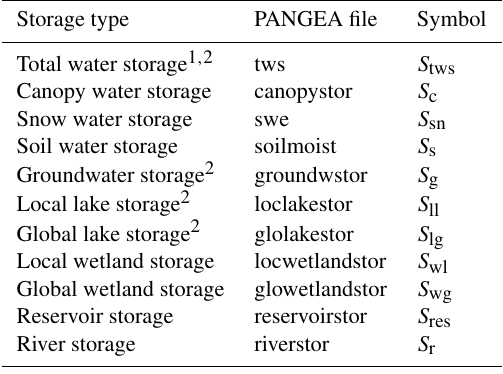
Table 1. Standard WaterGAP output variables: water storages. Units are kgm − 2 (mme . w . h . ). Temporal resolution is